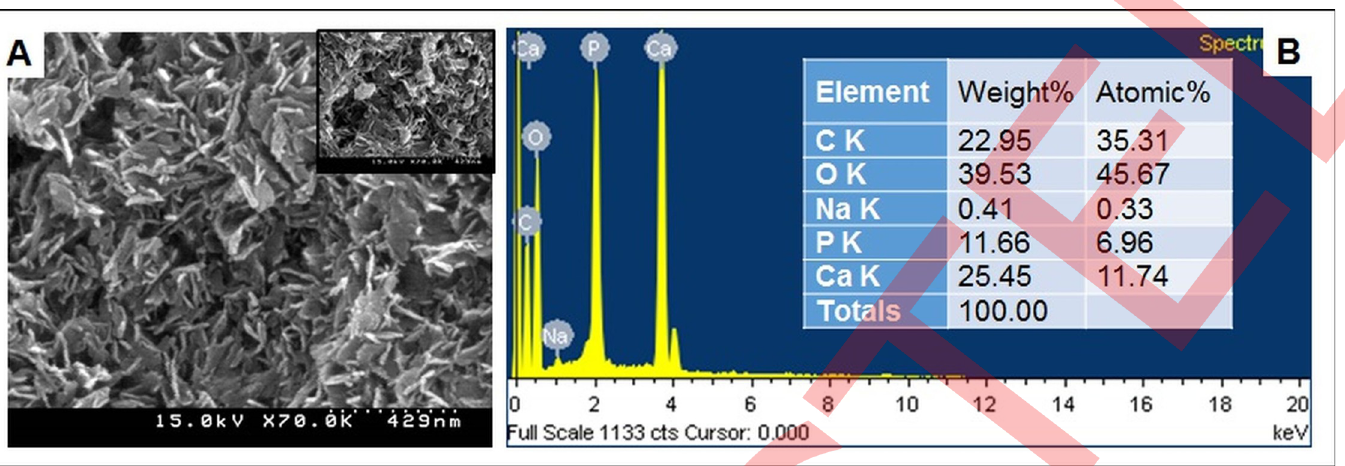
Fig 2. (A) SEM image of the synthesized CPG-S NPs; (B) EDS spectra of the synthesized CPG-S NPs (inset: percentage of different elements present in CPG-S NPs).